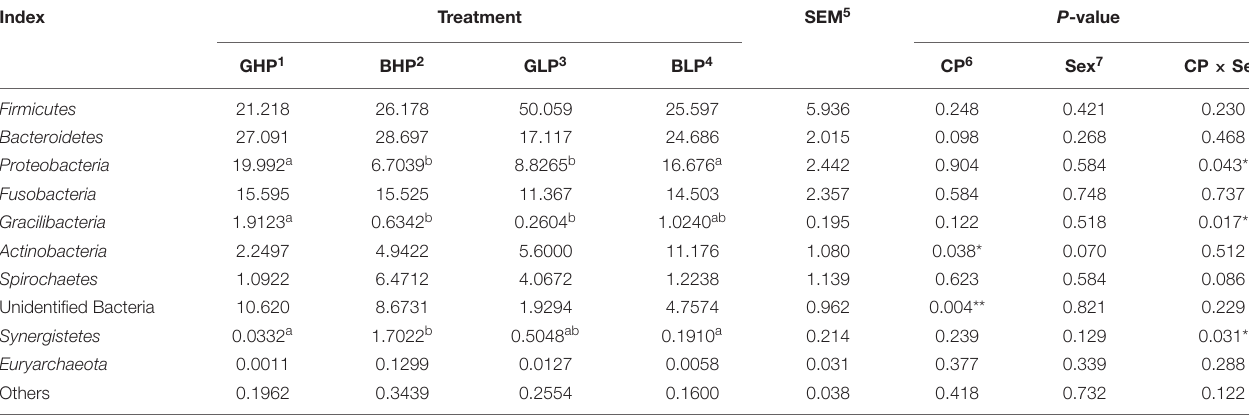
TABLE 2 | Relative abundance of microbial community (Top 10, %) structure in colonic content at phylum level from each group.